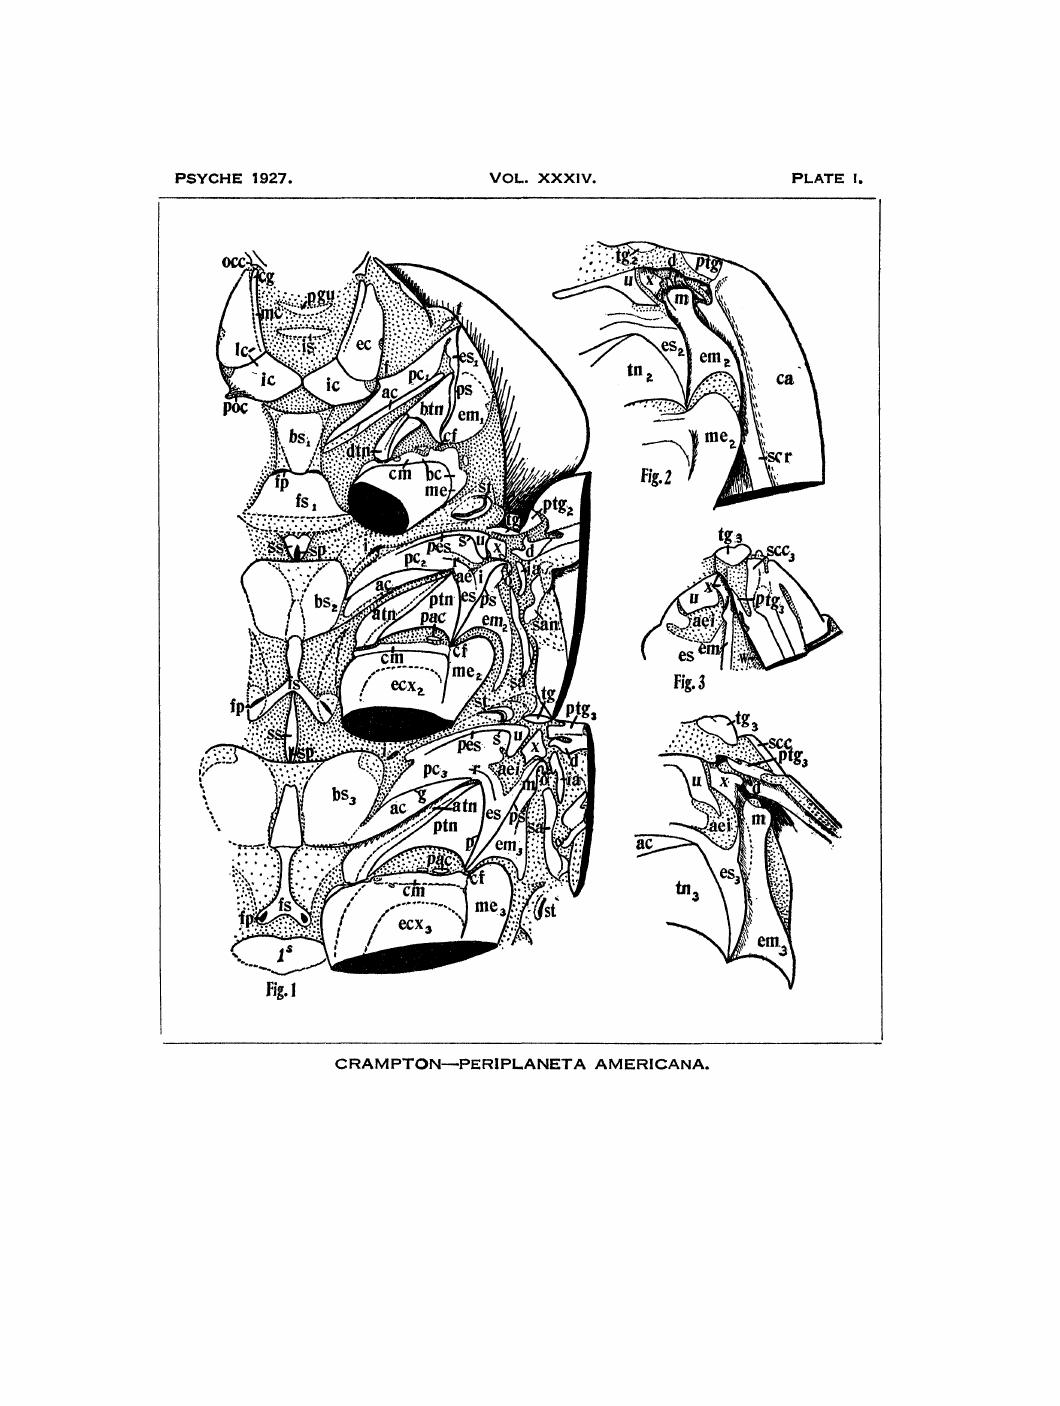
Fig.I CRAMPTON--PERIPLANETA